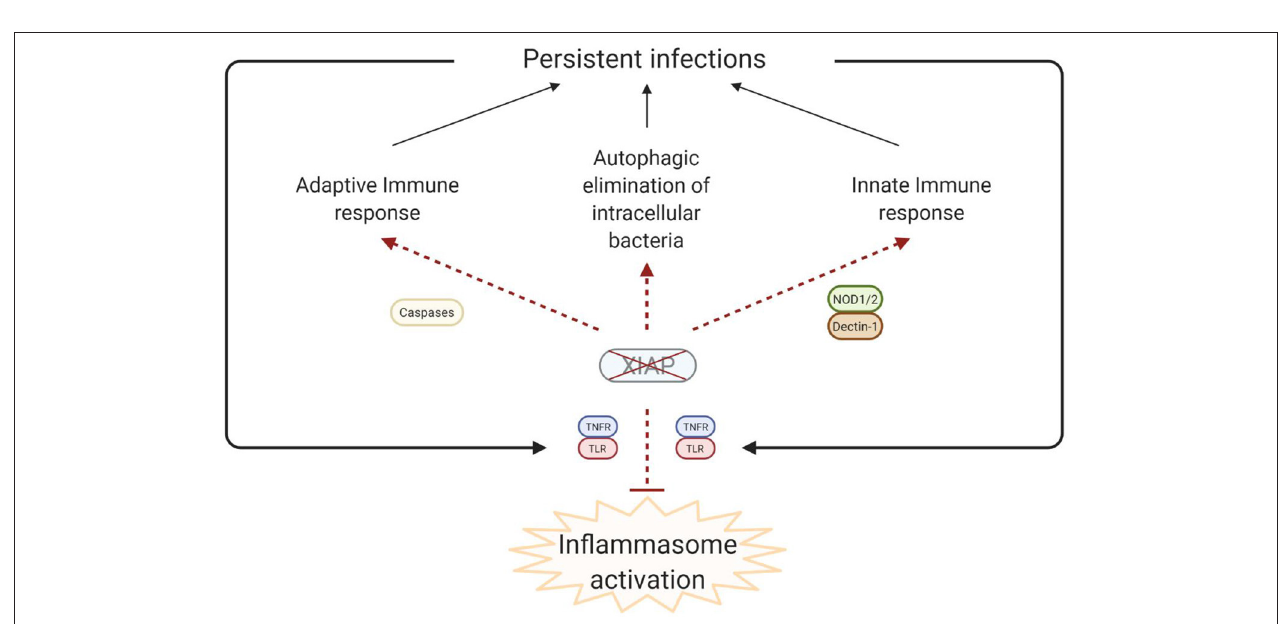
FIGURE 3 | NOD2 are intracellular PRRs that bind DAP and MDP, respectively (41, 42). Upon ligand binding, XIAP, together with cIAP1/2, ubiquitinates RIPK2, which subsequently acts as a scaffold for the TAK/TAB1 and IKK complexes, leading to activation of the MAPK and NF- κ B pathways, respectively (5, 36, 40). The TAK/TAB1 also links to the IKK complex, thereby inducing activation of the NF- κ B pathway (5, 36, 43, 44). Upon NOD activation, XIAP also recruits LUBAC, which in turn conjugates linear Ub chains to RIPK2. The concurrent ubiquitination of RIPK2 by XIAP and LUBAC is necessary for efficient activation of the canonical IKK for NF- κ B activation (36, 44, 45). (ii) XIAP is necessary in Dectin-1 signalling. Dectin-1 is a transmembrane PRR that detects β -glucan. Upon Dectin-1 stimulation, XIAP binds and ubiquitinates BCL-10, which is essential for the activation of the NF- κ B and MAPK pathways and cytokine production. BCL-10 is also involved in Rac1-dependent phagocytosis, which again relies on ubiquitination of BCL-10 by XIAP (28). (B) XIAP regulates the activation of inflammasomes via TLR/TNFR signalling. (i) Following TNFR1 and TLR signalling, RIPK3 can recruit RIKP1 to activate caspase-8 (46, 47). In this process, XIAP has an inhibitory effect on the ripopotosome by controlling the ubiquitination of RIKP1 in a RIPK3-dependent manner (6, 48). (ii) XIAP inhibits MLKL necroptotic signalling, which is promoted by RIPK3 in the absence of caspase-8 (48). (iii) TLR-MyD88 signalling causes the proteasomal degradation of cIAP1 and its adaptor TRAF2 by inducing TNF and TNFR2 signalling. This proteasomal degradation is inhibited by TLR-TRIF induced IFN- β . Loss of XIAP promotes LPS-induced cIAP1 degradation. Subsequently, cIAP1 loss in the absence of XIAP promotes TLR-induced RIPK3 caspase-8 and IL-1 β activity, eventually leading to IL-1 β maturation, caspase-8 cleavage and enhanced cell death (49). (iiii) TNFR2 activation acts as a signal 1 for priming the canonical inflammasome and induces expression of pro-inflammatory cytokines. XIAP loss and TNFR1 signalling play a role as signal 2 for activation of the inflammasome. This is mediated by RIPK1 and ROS production. In the absence of XIAP, TNFR2 stimulation leads to TNF production, followed by TNFR1 mediated cell death (50). Created with BioRender.com.